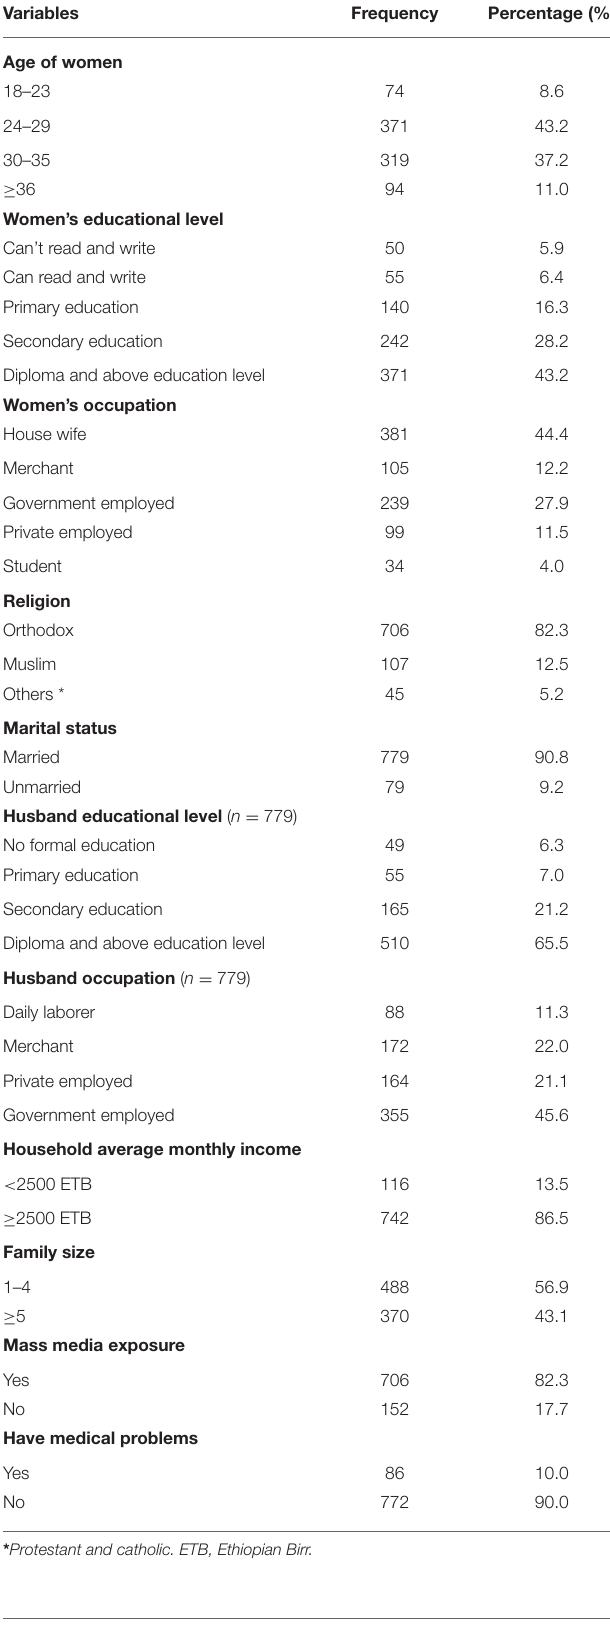
TABLE 1 | Socio-demographic characteristics of the study participants in Gondar city, northwest Ethiopia, 2021 ( n = 858).